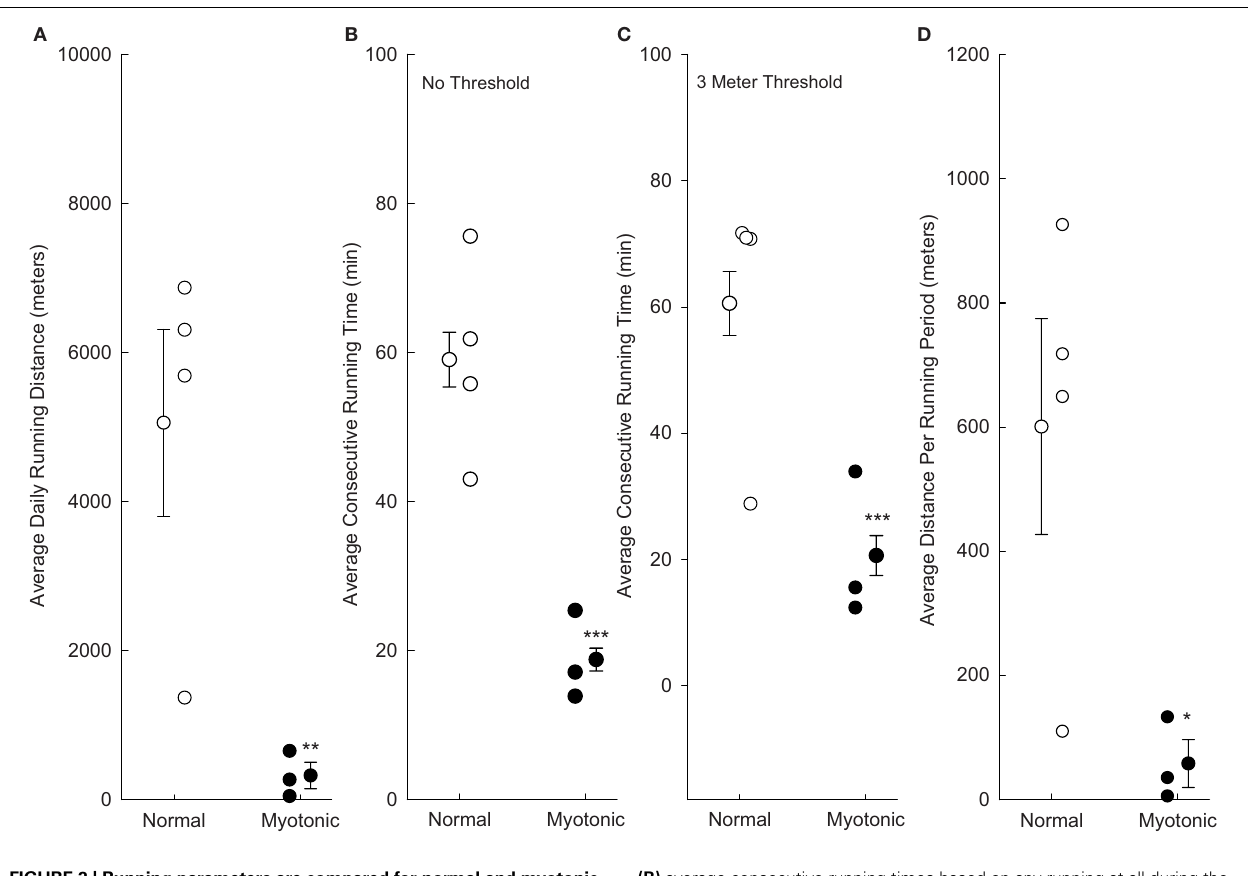
FIGURE 2 | Running parameters are compared for normal and myotonic mice during all of week 8. Data are depicted for individual animals (small circles) as well as mean values for each group of animals ( ± SE). Asterisks indicate statistical significance between normal and myotonic mice (* P = 0.048, ** P = 0.025, *** P < 0.001). (A) Total running distances per day;